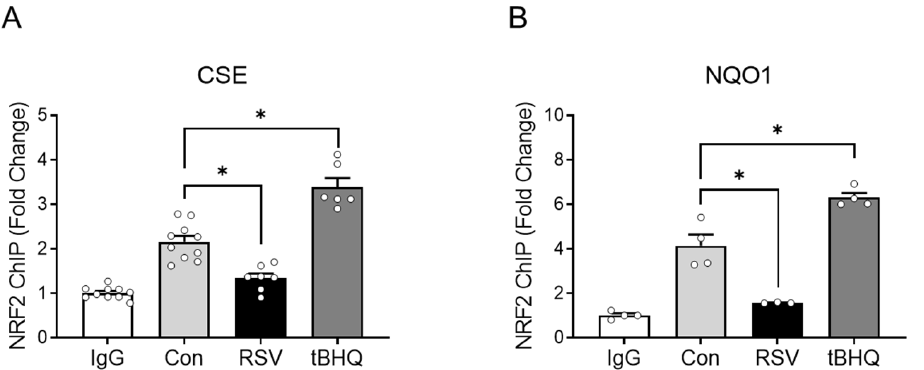
Figure 6. ChIP assay of endogenous CSE and NQO1 promoters. Chromatin from primary SAE cells infected with RSV for 20 h or treated with 25 µM tBHQ for 15 h was immunoprecipitated with anti-NRF2 antibody or IgG as negative control. qPCR was performed with immunoprecipitated DNA using primers spanning either the putative ARE site of the CSE promoter ( A ) or the NQO1 promoter ( B ). Fold change was calculated compared to IgG control. Data are expressed as mean ± SEM of three or four replicate data from two independent experiments (each circle represents individual data). * p < 0.05 relative to control